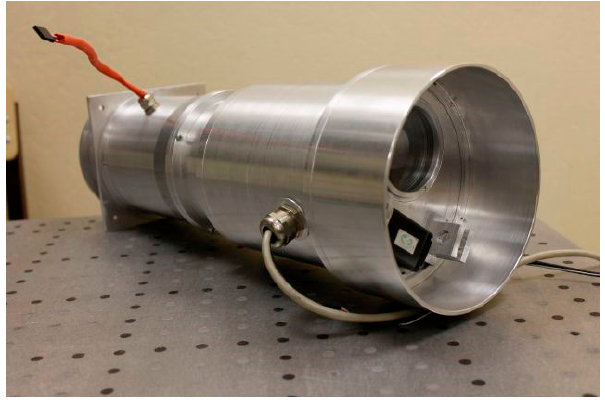
Figure 3. External appearance of prototype hyperspectrometer.